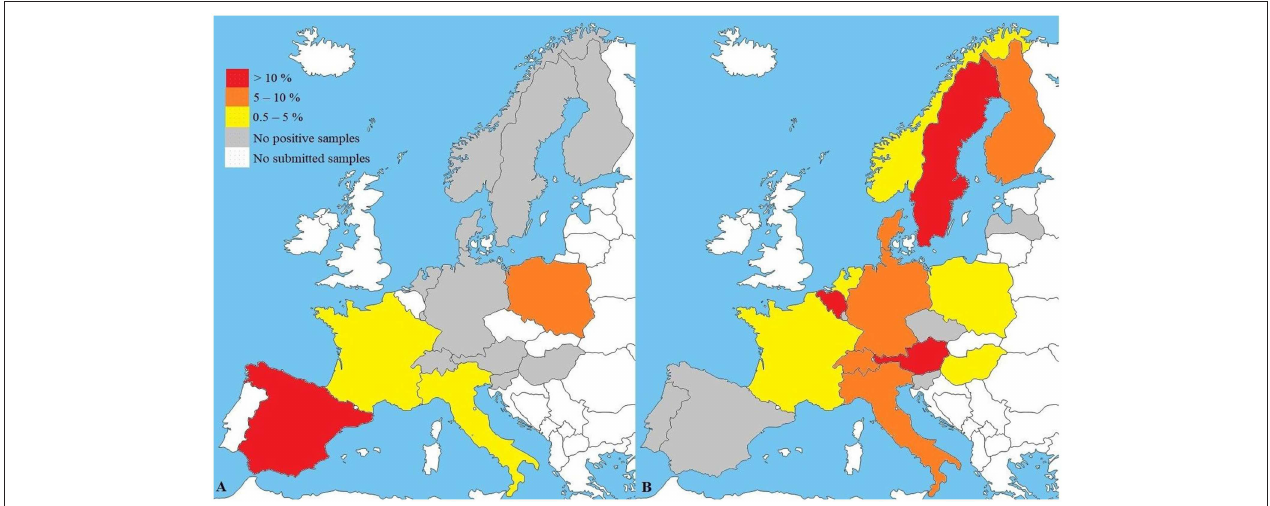
FIGURE 1 | (A ) Results of Brucella spp. PCR ( n = 1,657) and (B) B. canis antibody testing ( n = 2,764) in a veterinary diagnostic laboratory. Maps reflect preference to use PCR (A) or antibody tests (B) in respective countries. B. suis may not be recognized. Sample sizes and confidence intervals (CI 95 % ) for each country are described in Tables 2 , 3